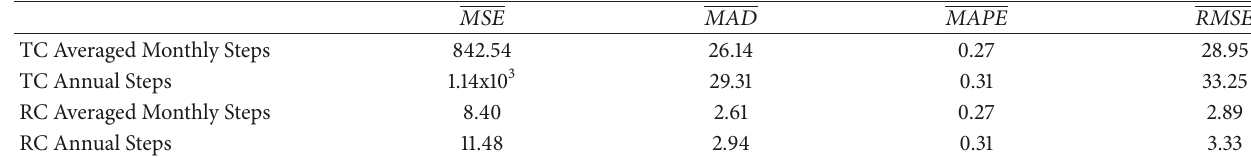
Table 9: Average for main measures of error for MR-OUP after 1000 MC simulations 2013-2017.